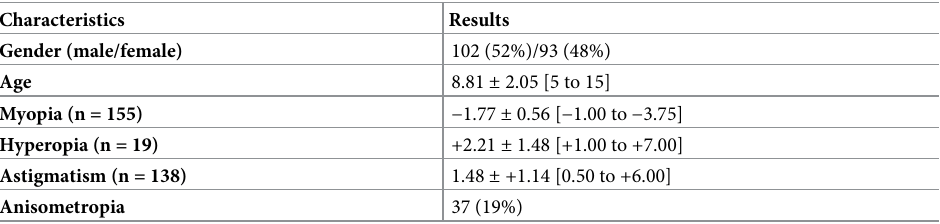
Values are presented as numbers (%) or mean ± standard deviation (range). Myopia: spherical equivalent (SE) � between the two eyes > 1.0D.